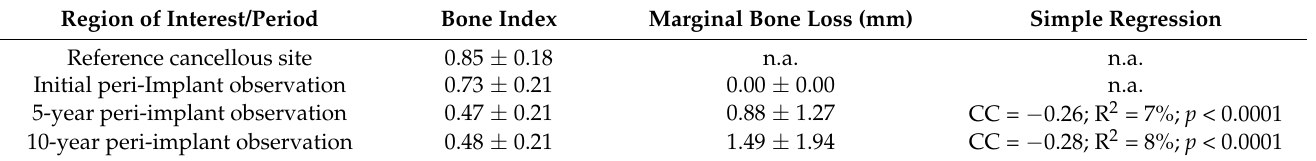
Figure 4. Relationship of crestal bone level to degree of corticalization. Due to the fact that the bone index is a measure of similarity to trabecular (cancellous) bone, therefore, the lower the bone index value, the more corticalized the bone is: ( a ) five-year observations for both variables; ( b ) five-year bone index compared to marginal bone loss noted at the ten-year examination, i.e., predicting whether marginal bone loss will occur after ten years if a given level of bone index value is observed in the fifth year of observation; ( c ) ten-year observations for both variables. The vertical lines in the boxes indicate the median value. Asterisks indicate statistically significant differences. All occurred at the p < 0.0001 level. MBL-marginal bone loss; 5y, 10y—five- and ten-year observations.